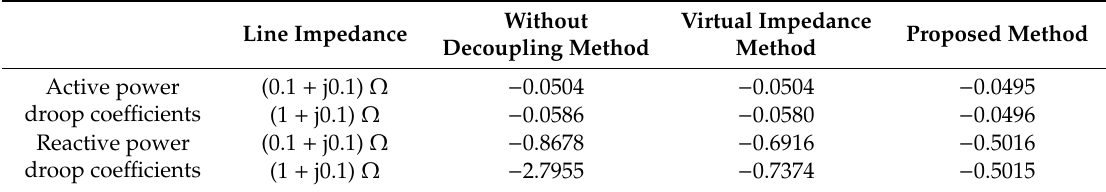
Table 3. Terminal droop coe ffi cients of connecting lines with di ff erent R / X